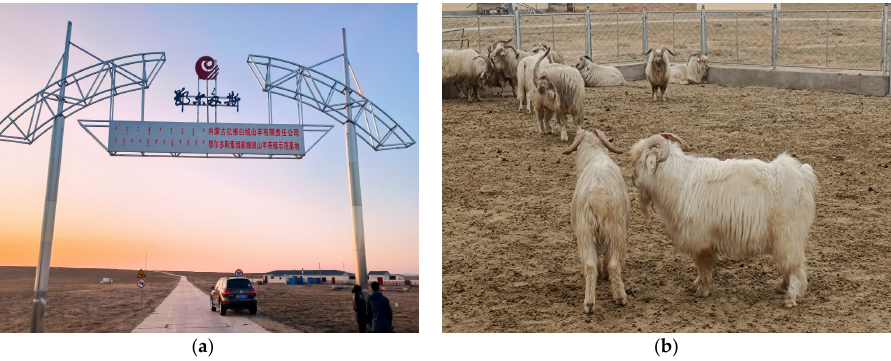
Figure 20. Field test site. ( a ) The Sanbei goat farm in Erdos. Erdos, Inner Mongolia Yivi White Velvet Goat Co., Erdos Group Superfine Velvet Goat Breeding Demonstration Base. ( b ) Albas white cashmere goats